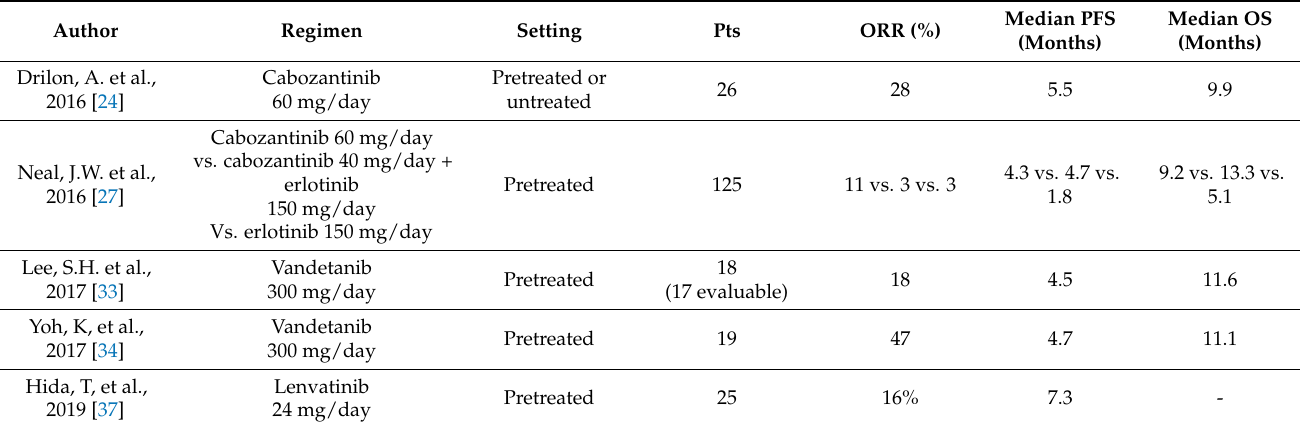
Table 1. Non-selective RET inhibitors in RET+ NSCLC